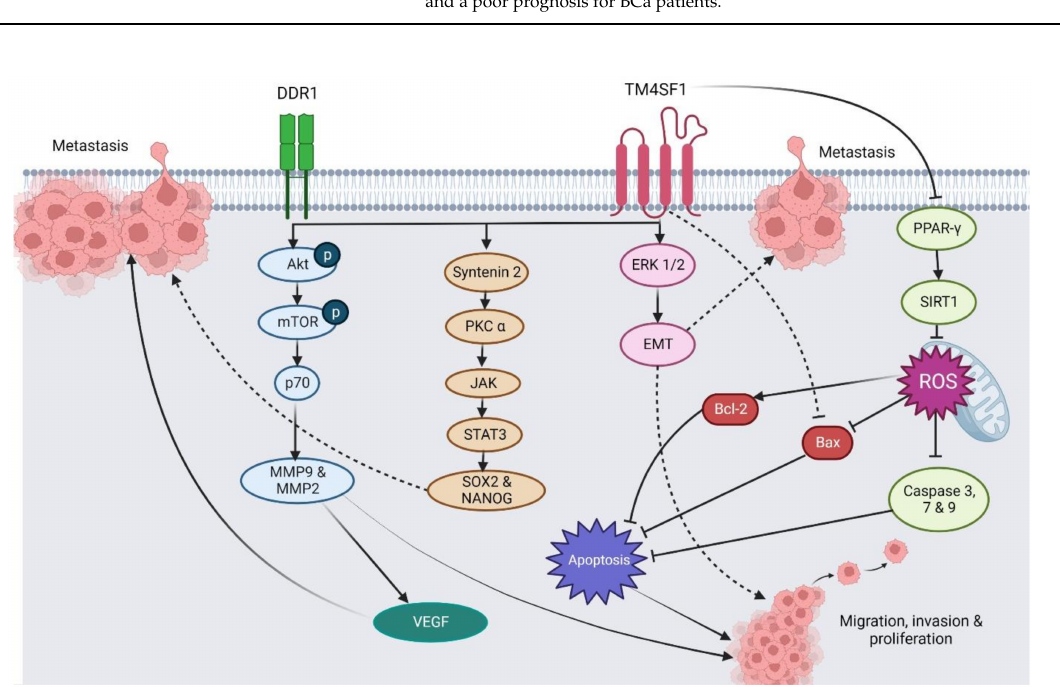
Figure 2. The proposed mechanism underlying the roles of TM4SF1 toward cancer phenotypes and